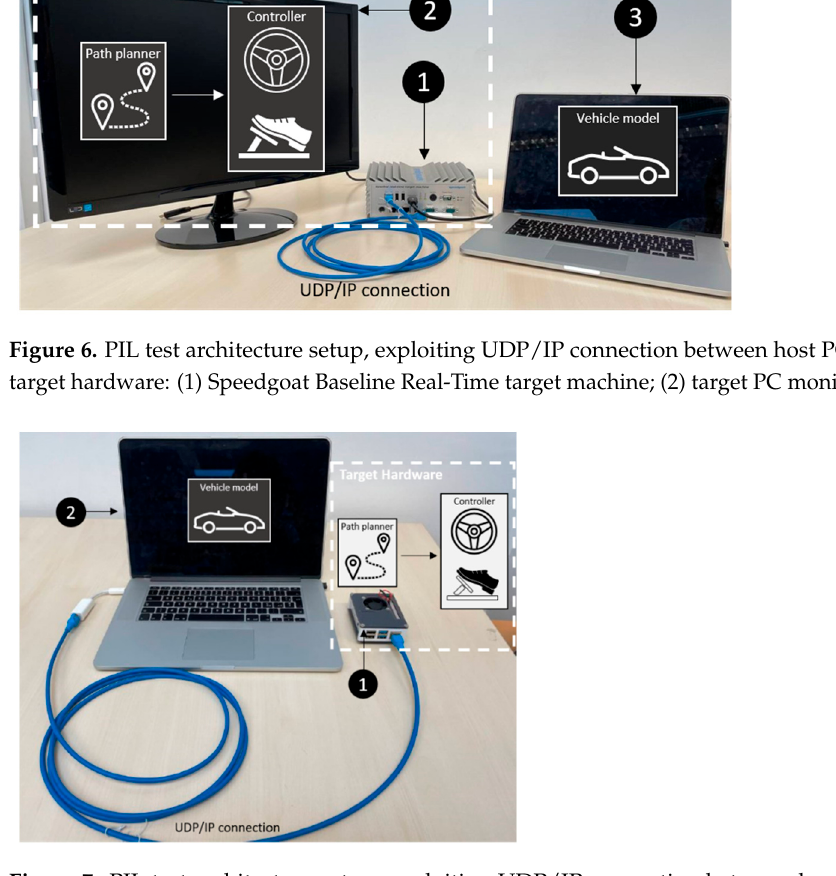
Figure 7. PIL test architecture setup, exploiting UDP/IP connection between host PC and target hardware: (1) Raspberry Pi 4B board; (2) host PC.